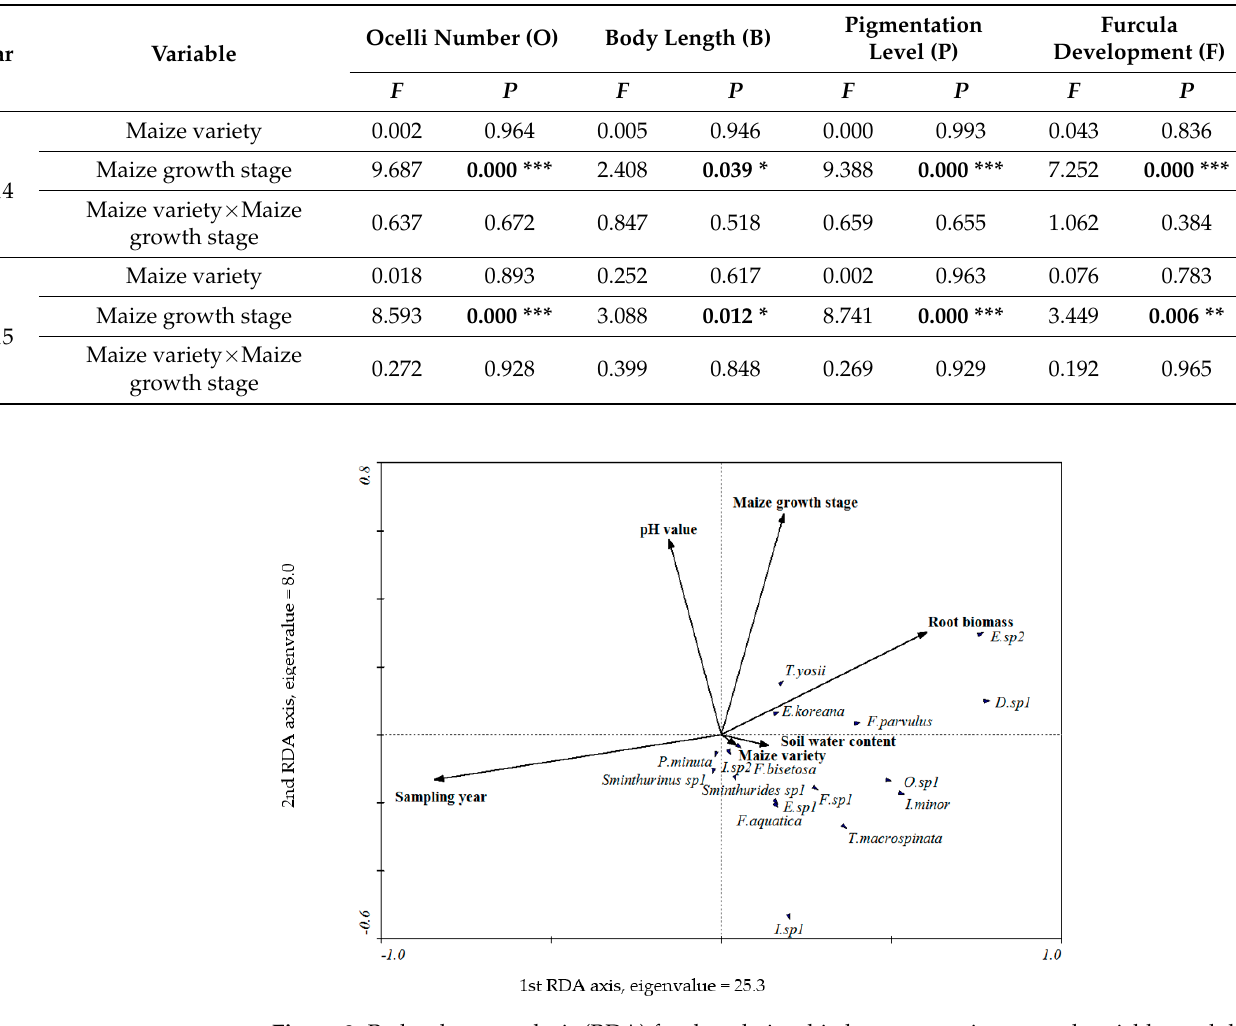
Table 4. Effects of maize variety (Bt maize and non-Bt maize) and maize growth stage on collembolan morphological trait attribute values (CWM), analyzed using a two-way ANOVA. The values highlighted in bold are statistically significant (* p < 0.05; ** p < 0.01; *** p < 0.001).